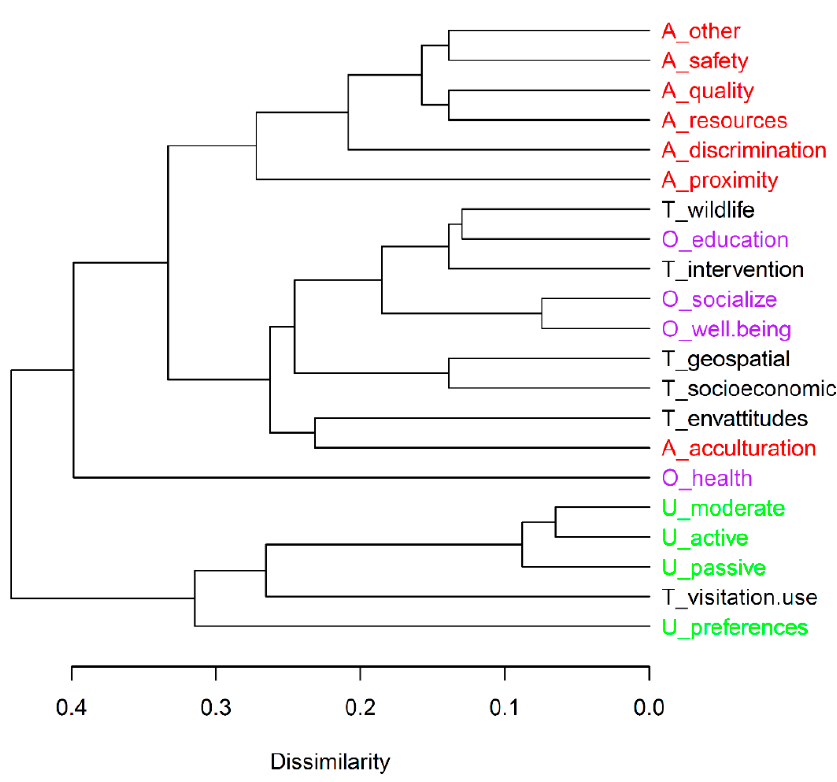
Figure 4. Hierarchical clustering of research topics according to published studies. Research topic labels are prefixed with the initial of the category (T = Theme, U = Use, O = Outcomes, A = Access) to which it belongs. Four clusters of research topics emerge by applying a phenon line at a dissimilarity value of 0.32.